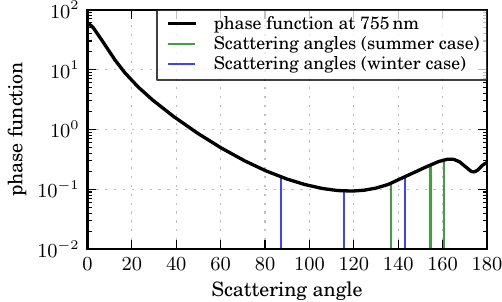
Fig. 4. Phase function of the aerosol type used in this study. Scat- tering angles for the summer and winter case are indicated by green and blue lines,